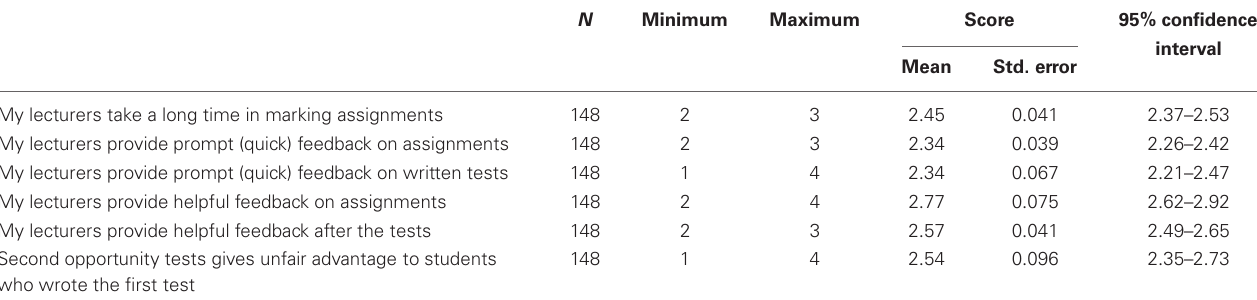
Table 3 | Provision of feedback to the students on assessment tasks.